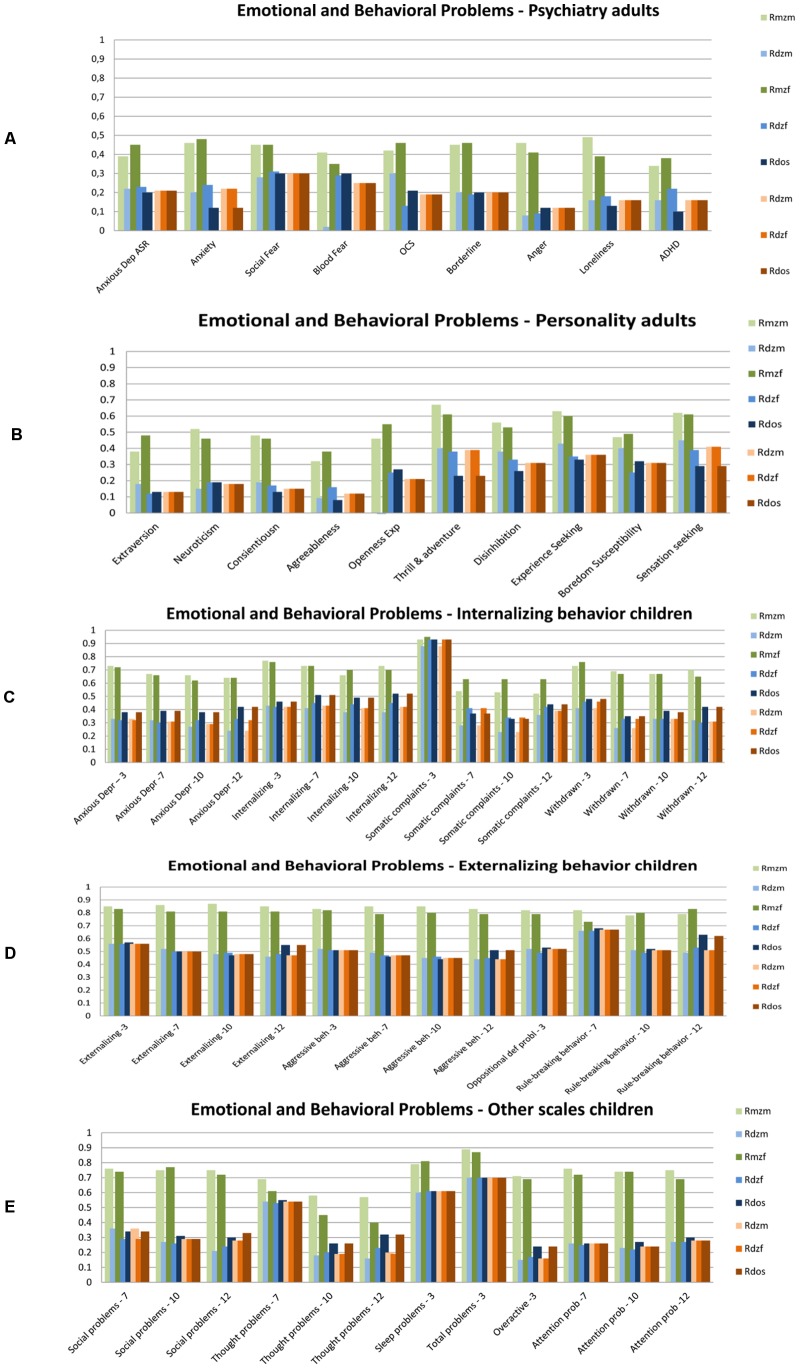
Twin correlations for Behavioral and Emotional Problems.1A: adult psychiatry, 1B: adult psychology, 1C Internalizing behavior in children, 1D Externalizing behavior in children, 1E other scales in children. The green bars represent correlations in Monozygotic Male (MZM) twin pairs (light green) and Monozygotic Female (MZF) twin pairs. The blue bars represent correlations in Dizygotic Male (DZM) twin pairs, Dizygotic Female (DZF) twin pairs and Dizygotic Opposite Sex (DOS) twin pairs. The green and blue bars reflect the correlations in a full model, while the orange bars reflect twin correlations for Dizygotic (DZ) twin pairs in the most parsimonious model, with: DZM (light orange), MZF (normal orange), DOS (dark orange).